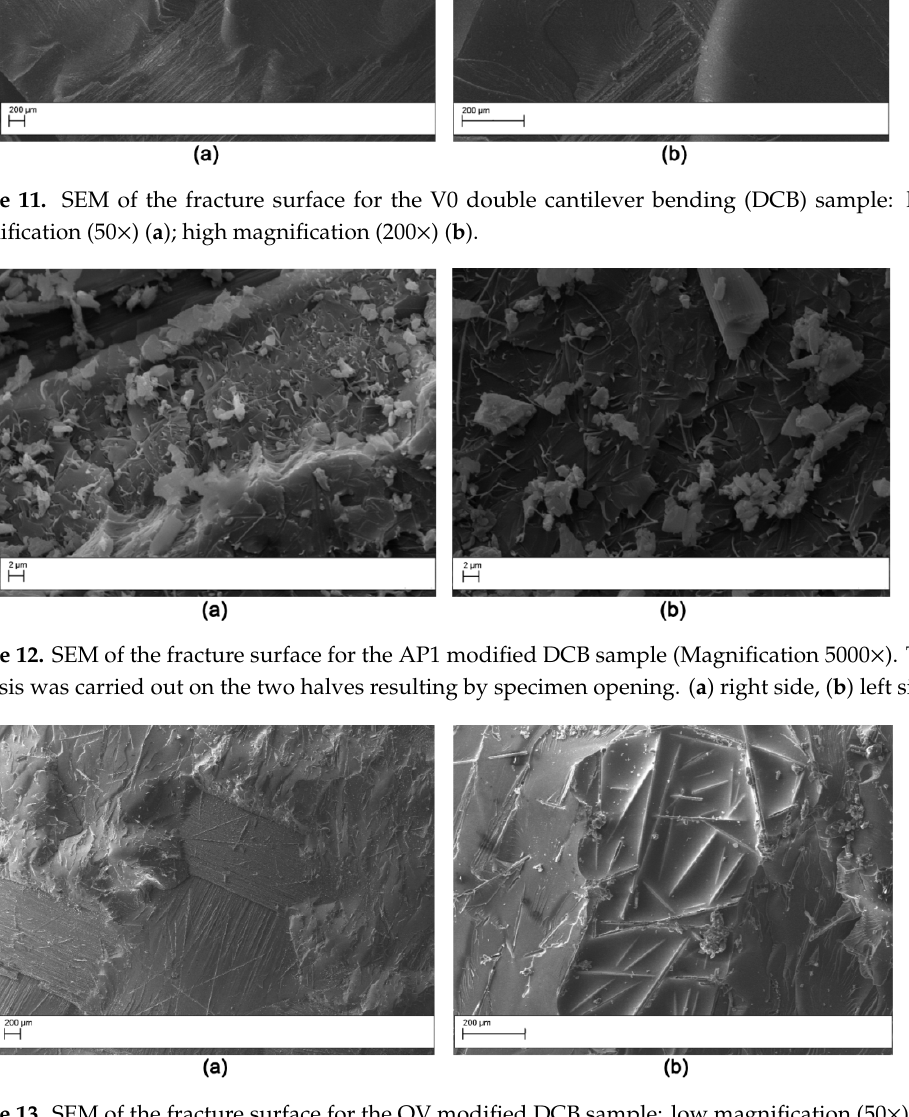
Figure 13. SEM of the fracture surface for the OV modified DCB sample: low magnification (50×) ( a ); high magnification (200×) ( b ).